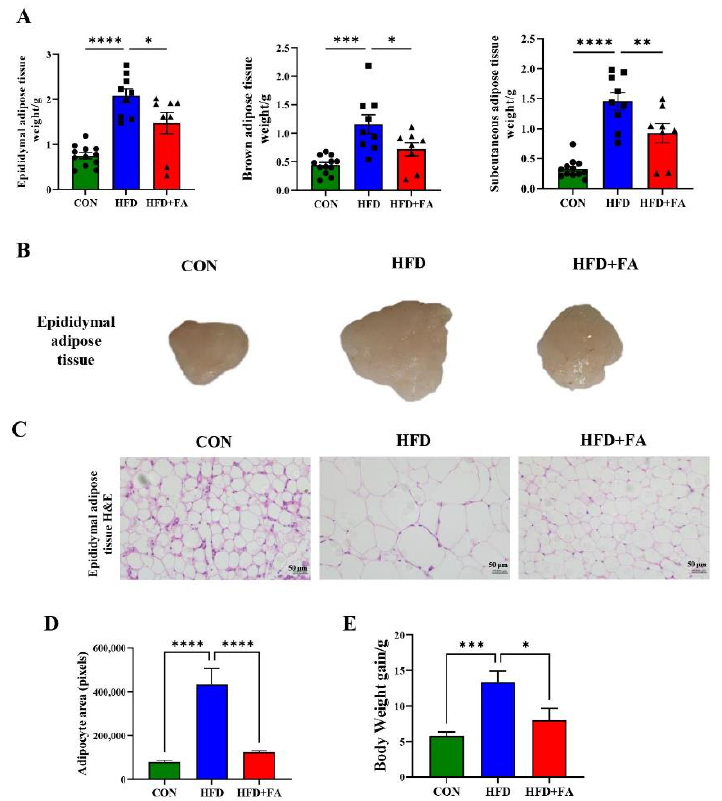
Figure 2. FA reduces expansion of adipose tissue. ( A ) Epididymal, brown and subcutaneous adipose tissue weight (g) in mice from the three groups, CON, HFD, and HFD+FA ( n = 10). ( B ) Representative images of epididymal adipose tissue in mice from the three groups, CON, HFD, and HFD+FA. ( C ) Representative images of hematoxylin and eosin (H&E)-stained epididymal adipose sections of mice from the three groups, CON, HFD, and HFD+FA at endpoint (12 weeks). Scale bars, 50 µ m. ( D ) Distribution of average epididymal adipocyte area of mice from the three groups, CON, HFD, and HFD+FA. ( E ) Body weight gain of mice from the three groups, CON, HFD, and HFD+FA at endpoint. Data are shown as mean ± SEM. * p < 0.05, ** p < 0.01, *** p < 0.001, **** p < 0.0001.